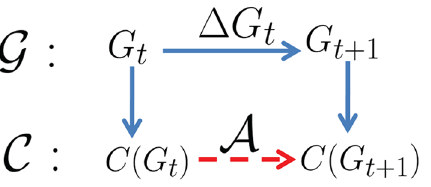
Figure 1. The overview of our adaptive community structure detection